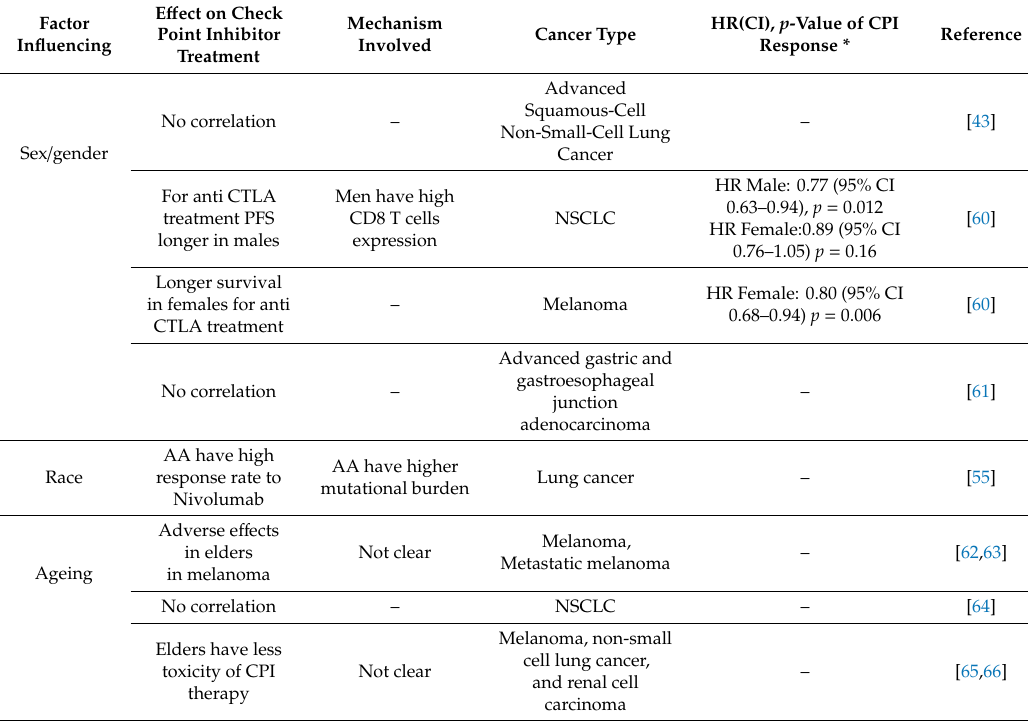
Table 2. E ff ect of sociological factors in modulating CPI